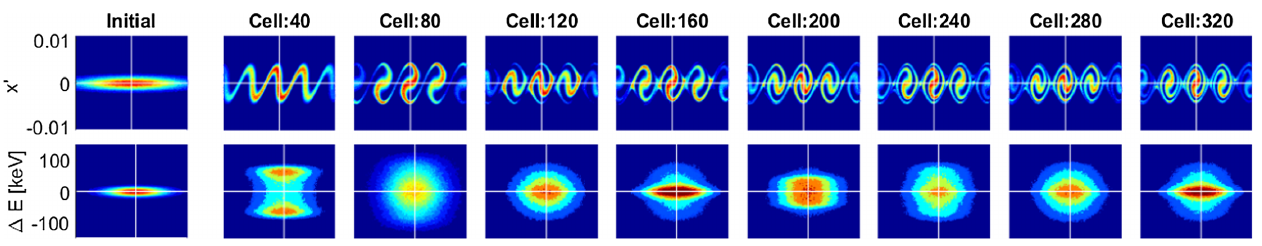
FIG. 21. Horizontal and longitudinal phase space for every fortieth cell for ε 1 . 3 < φ < 1 . 8 . Two periods of transverse oscillations are visible [cf. Eq.